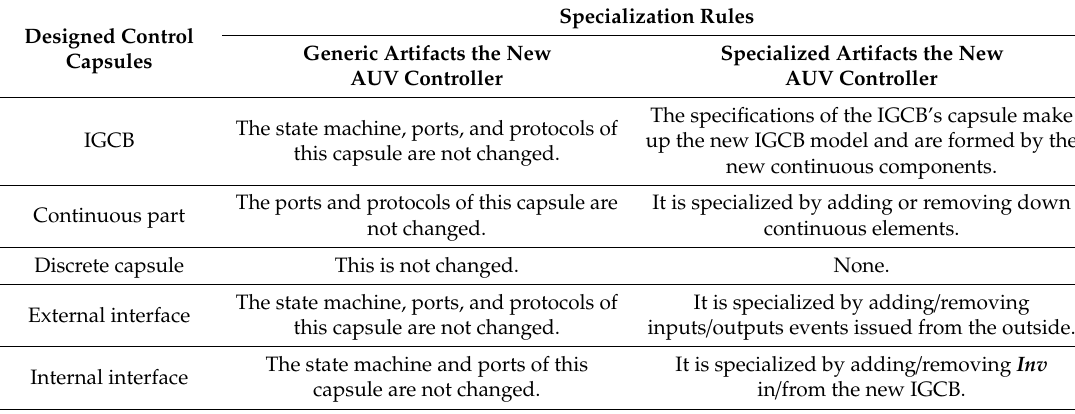
Table 2. The customizability and reusability of designed control capsules in new control applications for many types of AUVs. IGCB, instantaneous global continuous